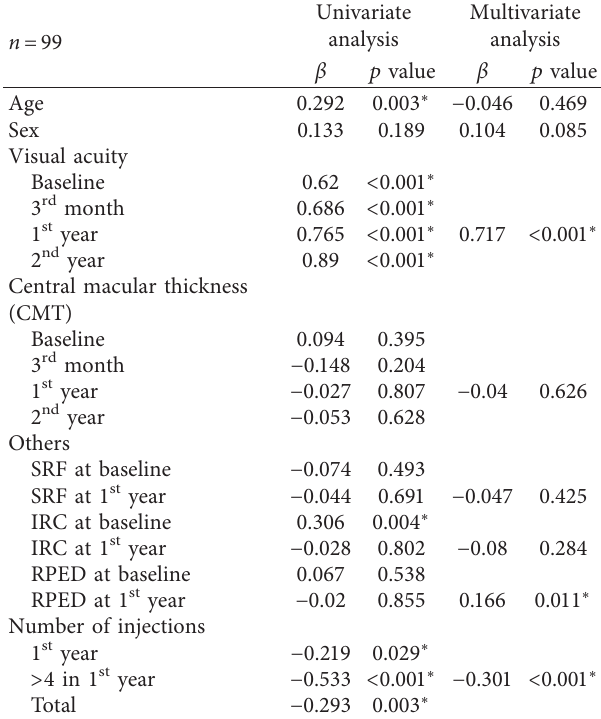
Table 1: Univariate and multivariate analysis for visual outcome at the third year in the complete 3-year follow-up group ( n � 99). n � 99